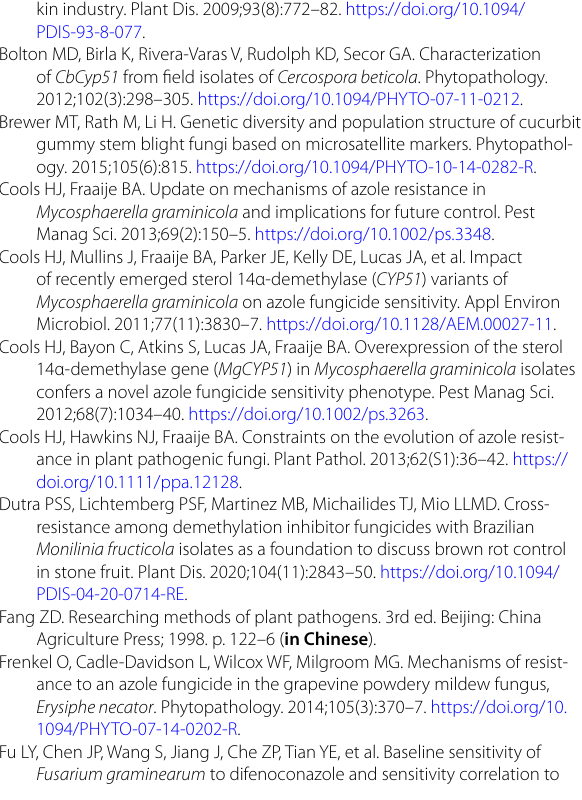
Table S2. Series concentration for determine EC 50 of difenocona- zole, tebuconazole, prochloraz, hexaconazole, metconazole, and